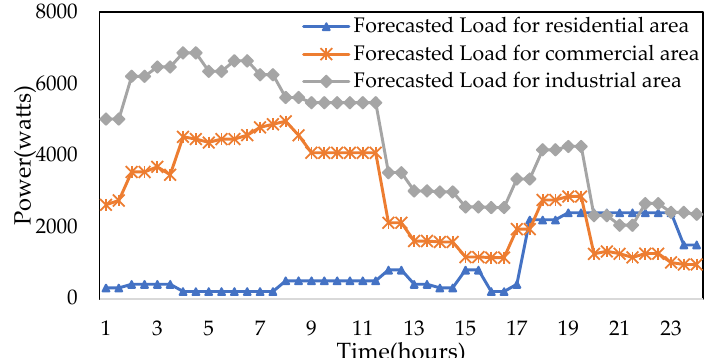
Figure 4. Forecasted load demands of all three areas. Table 2. Details of the residential load.